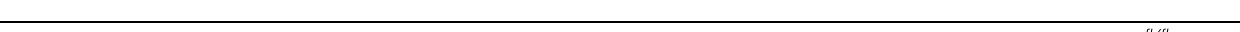
Fig. 4 CDKN1A repression by EZH2 is required for GC B cell cycle progression. a – f Organoids were generated using B cells isolated from Ezh2 fl / fl ;C γ 1-cre, Cdkn1a − /